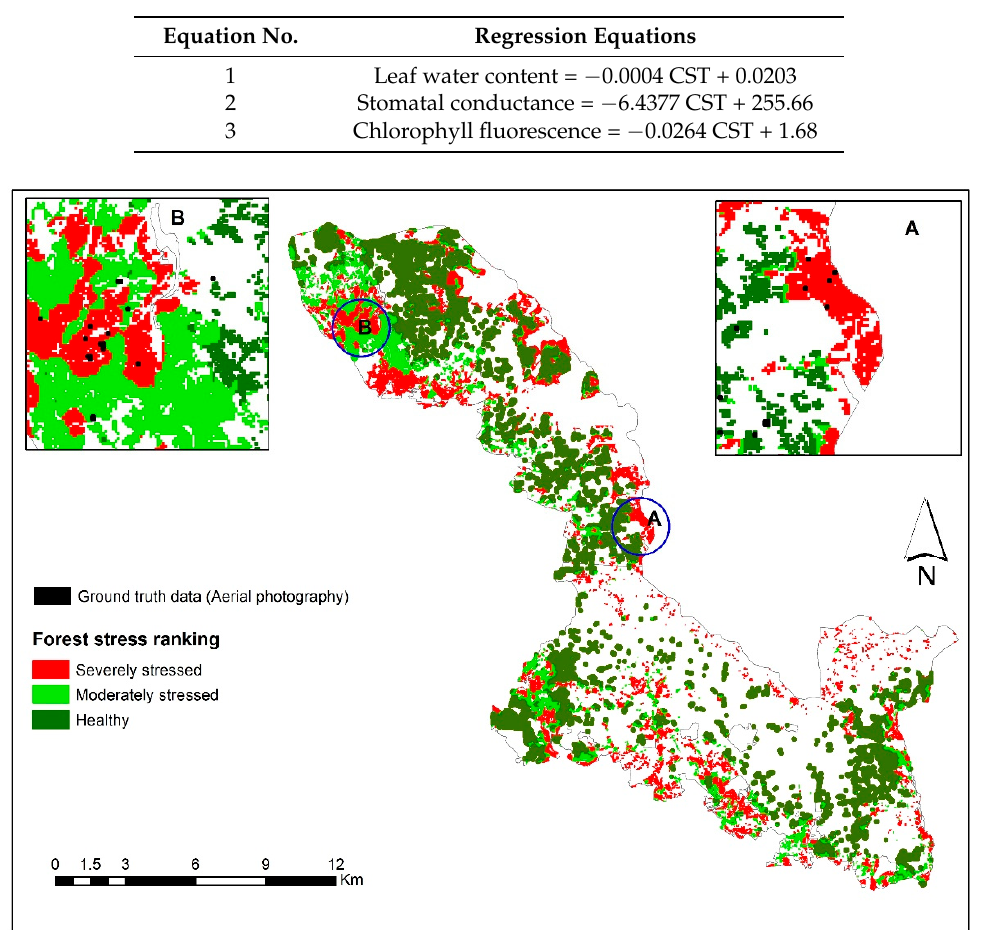
Table 4. Regression equations between canopy surface temperature (CST) and measured leaf properties.